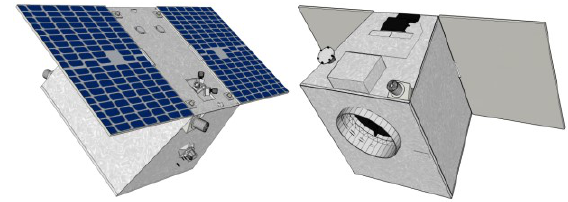
Figure 4. CO3D satellite views